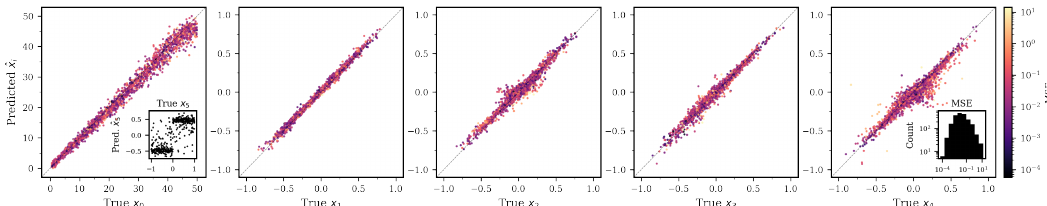
Figure 7: True Stevens coefficients x versus predicted coefficients ˆ x for tetrag- i i = 4000 data sets. The onal 4mm point group and J = 15 / 2 for N testing color denotes the MSE and the inset histogram in the right most panel shows the distribution of the MSE. This network was trained using nine 1D observable ( T , b ) , χ ( t ) , c ( t ) } . The MAEs of the Stevens coefficients are data sets, { µ a i a i M i { MAE ( 0 ) ,...,MAE ( 4 ) } = { 1.380 K,0.022,0.038,0.031,0.059 } . The sign of x was 5 correctly predicted correctly in 93% of the cases (see inset in left most panel). The average MSE is 〈 MSE 〉 =